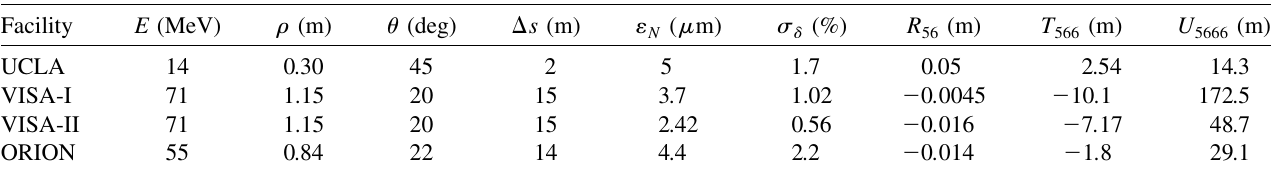
TABLE I. Various parameter values for the dogleg sections of Fig.